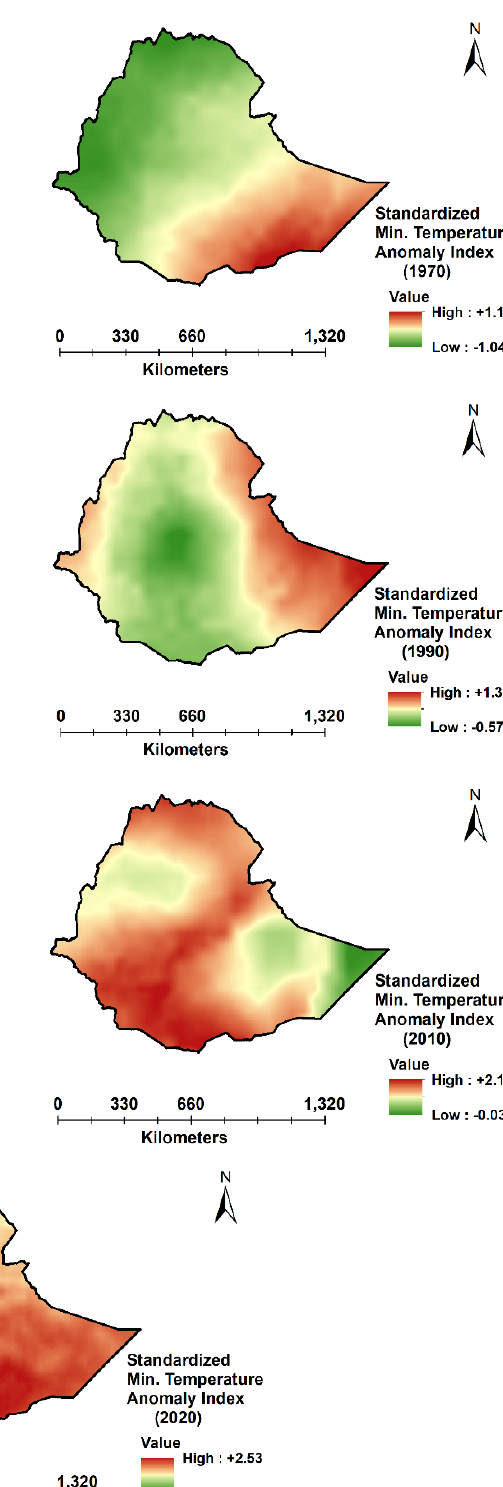
Figure 5. Standardized max. temperature anomaly index maps for 1960, 1970, 1980, 1990, 2000, 2010, and 2020 in the study of Ethiopia.